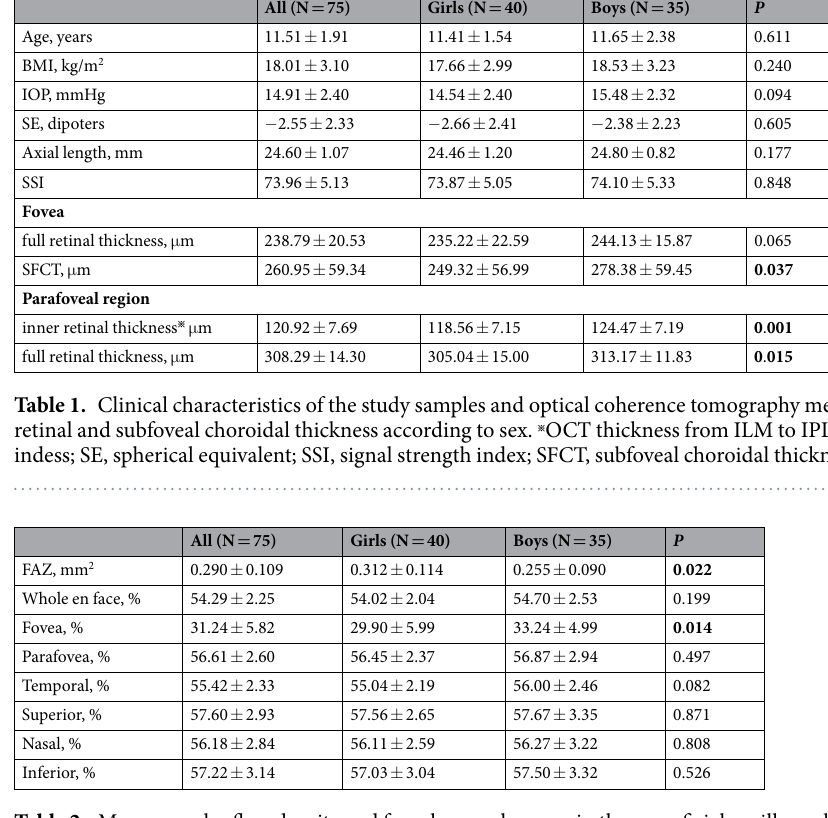
Table 2. Mean vascular flow density and foveal avascular zone in the superficial capillary plexus measured by OCT angiography according to